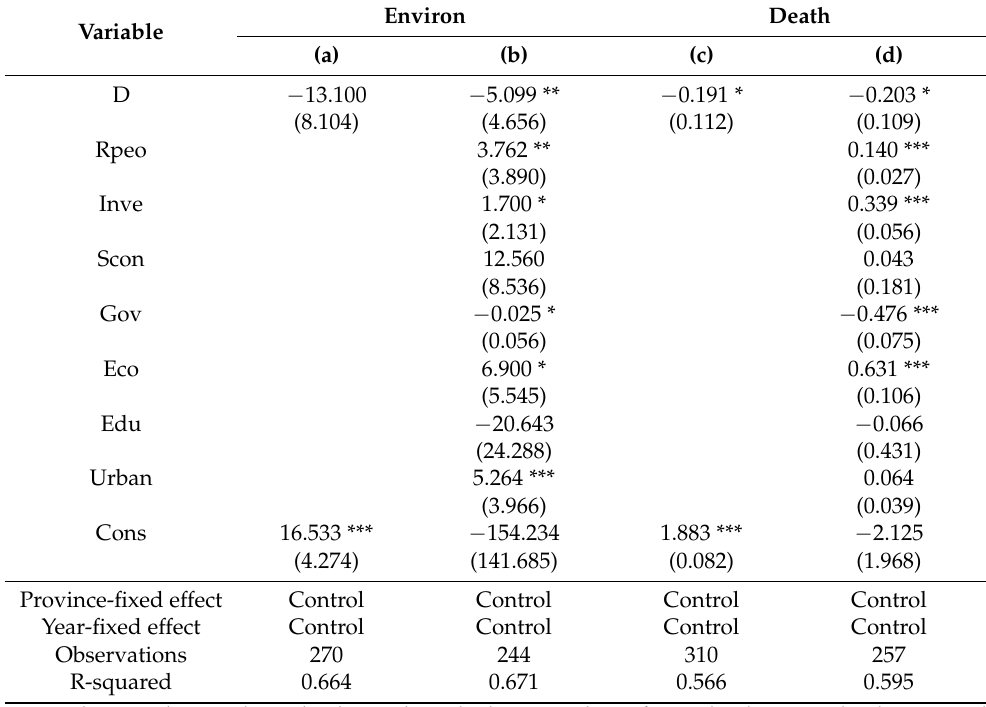
Table 4. Robustness